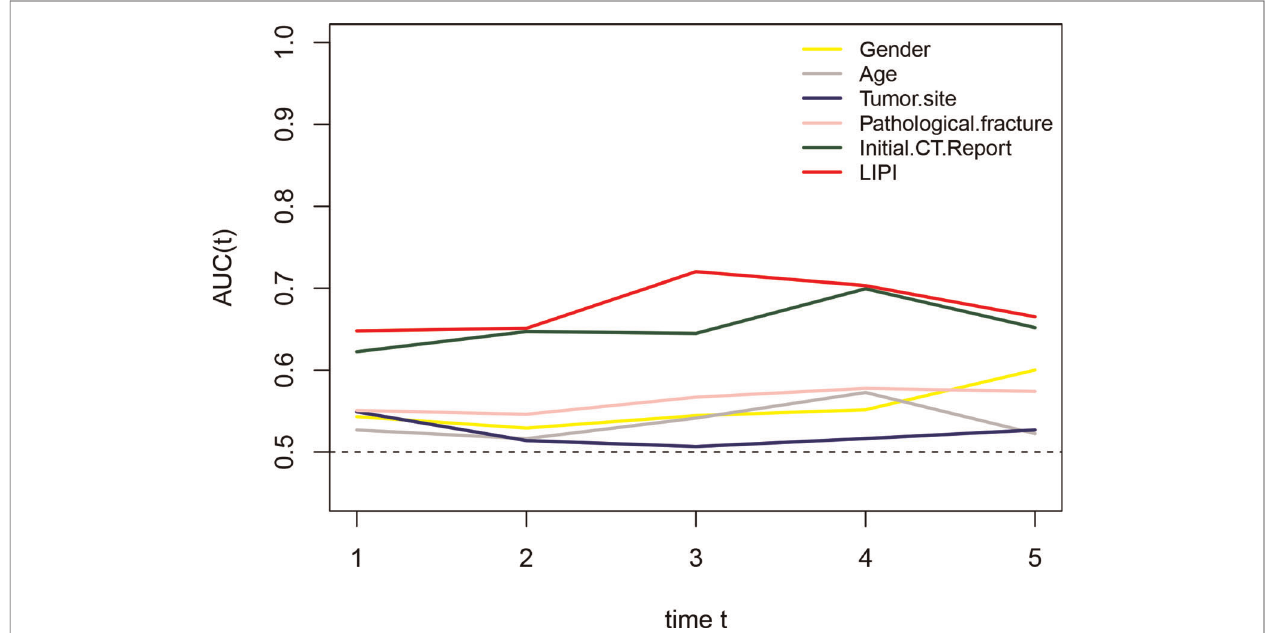
FIGURE 5 | Comparison of the metastatic predictive effect between LIPI and clinical features. A larger AUC in the t-ROC means a better predictive